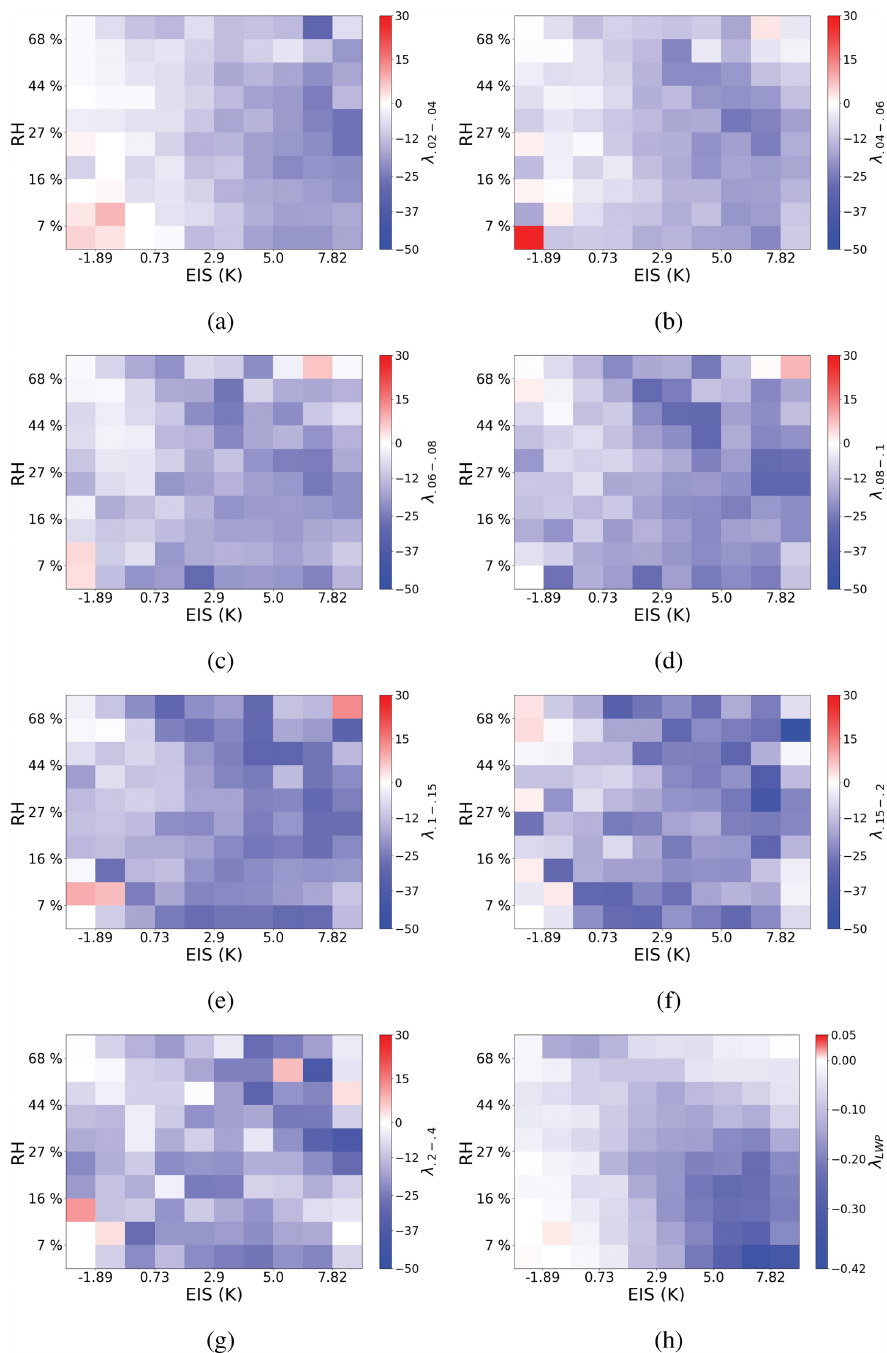
Figure 6. The sensitivity of CRE to aerosol ( λ BOTH ) found with constraints on stability, RH 700 , and cloud state limits of (a) 0.02 to 0.04kgm − 2 ( − 3 . 7Wm − 2 ln(AI) − 1 ), (b) 0.04 to 0.06kgm − 2 ( − 2 . 2Wm − 2 ln(AI) − 1 ), (c) 0.06 to 0.08kgm − 2 ( − 1 . 4Wm − 2 ln(AI) − 1 ), (d) 0.08 to 0.1kgm − 2 ( − 1 . Wm − 2 ln(AI) − 1 ), (e) 0.1 to 0.15kgm − 2 ( − 1 . 5Wm − 2 ln(AI) − 1 ), (f) 0.15 to 0.2kgm − 2 ( − 0 . 5Wm − 2 ln(AI) − 1 ), and (g) 0.2 to 0.4kgm − 2 ( − 0 . 4Wm − 2 ln(AI) − 1 ). Panel (h) is the summed, weighted sensitivity λ BOTH within each environmental regime. The weighted, summed sensitivity is − 10 . 6Wm − 2 ln(AI) − 1 (sum of panel h ). Note that the color bar for panel (h) is adjusted due to